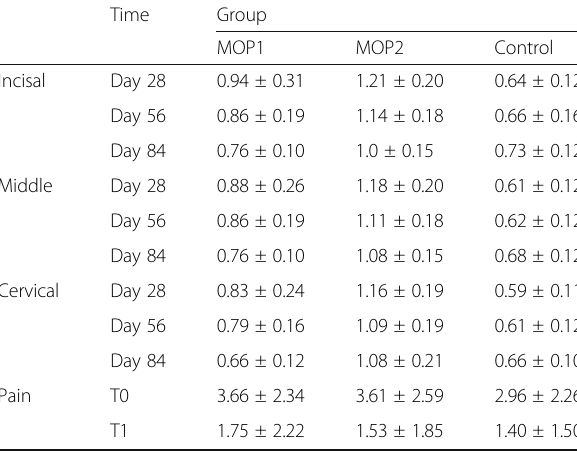
Table 2 Canine movement values (mm) and pain values (VAS results) of the MOP1, MOP2, and control groups. Data are expressed as mean ±